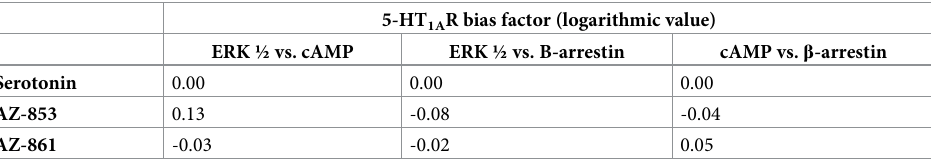
Table 2. Bias factors of compounds AZ-853 and AZ-861 and reference agonist serotonin at 5-HT 1A